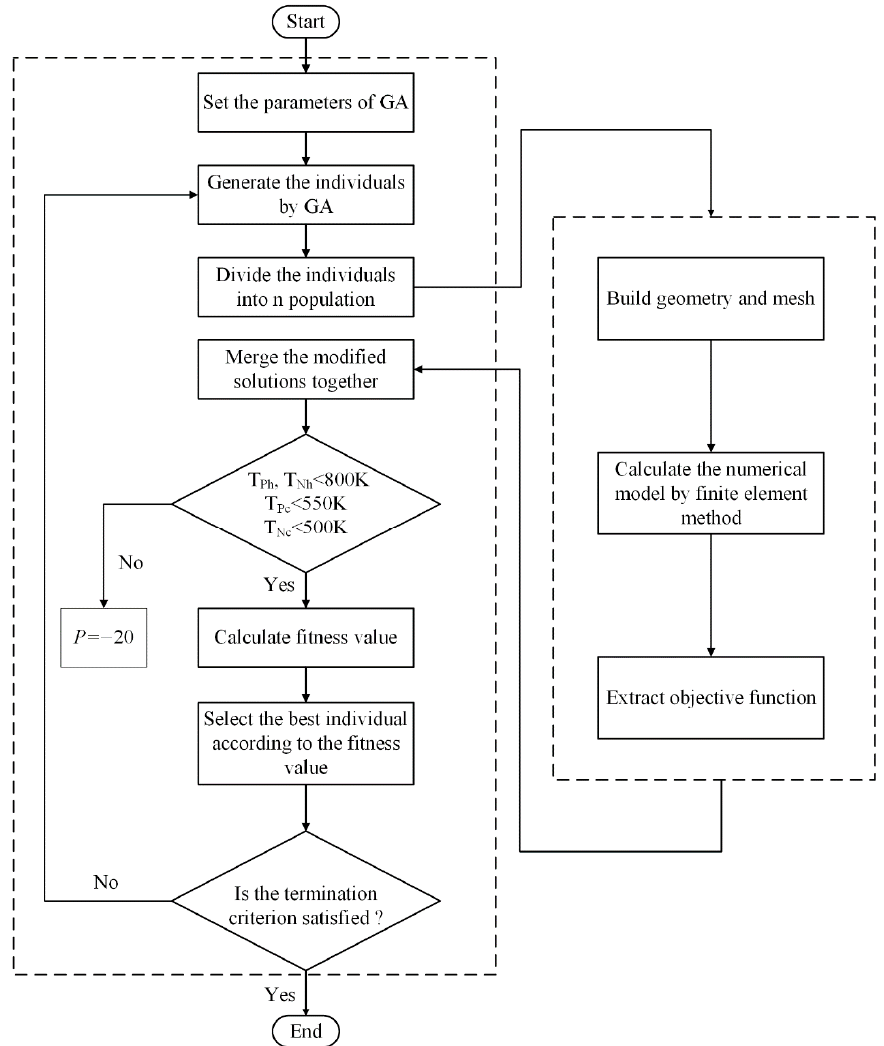
Figure 2. Flow chart of the optimization.